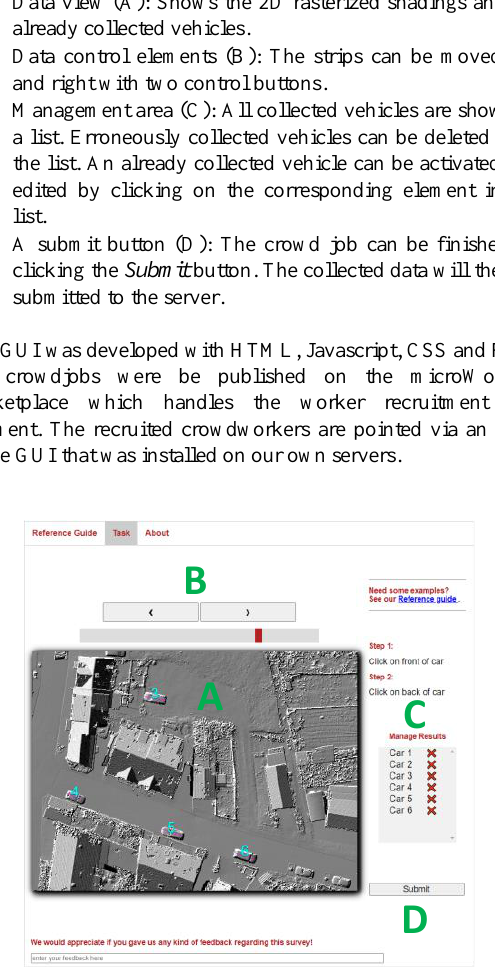
Figure 3. GUI for the coarse identification of